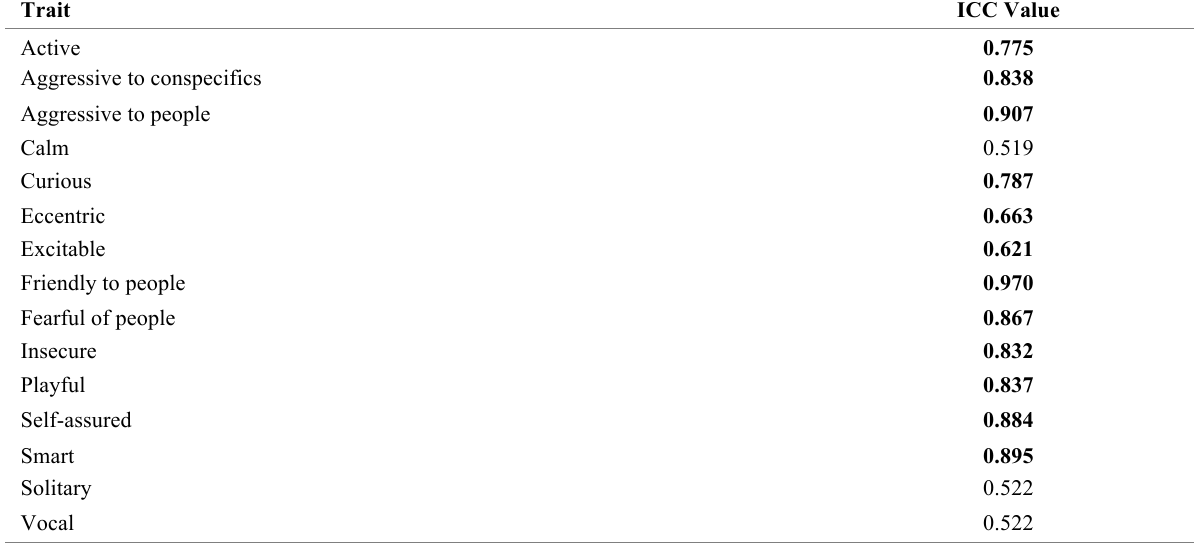
Intra-Class Correlation (ICC) Values for All Personality Traits from Keeper Surveys